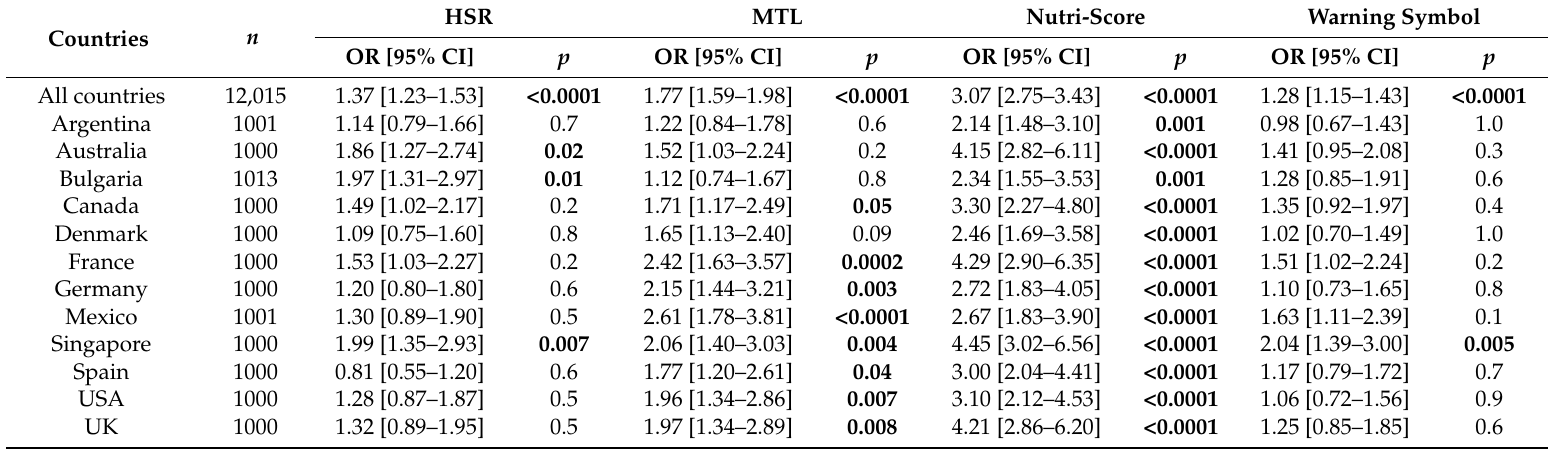
Table 2. Associations a between FoPLs and change in ability to correctly rank products between no label and labelling